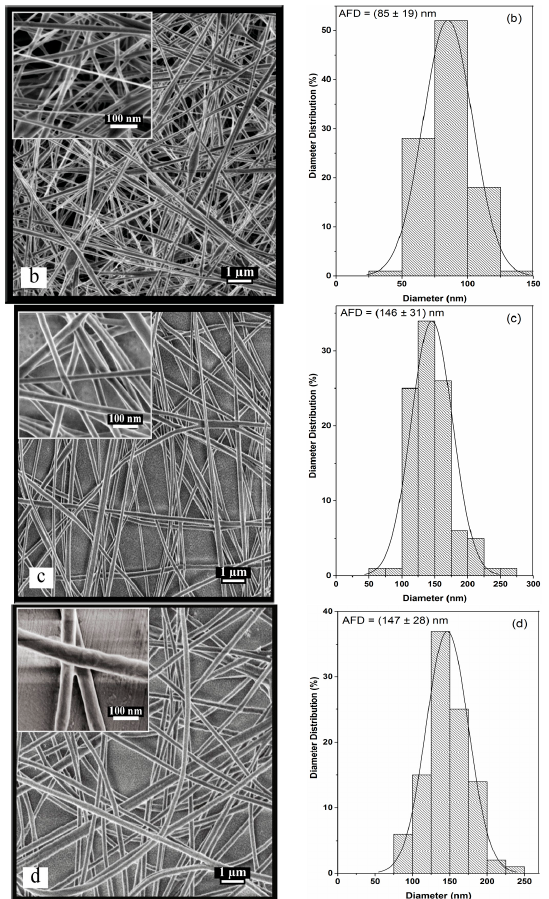
Figure 3. Representative SEM images and fiber diameter distributions of the electrospun nanofibers obtained from blend of powdered PEO into chitosan solutions (CS/PEO) at weight ratio ( a ) 90/10; ( b ) 80/20; ( c ) 70/30; and ( d ) 60/40. The insets show the high magnification images. The fiber diameter distributions of each are shown on the right. AFD: average fiber diameter; SEM: scanning electron microscopy.